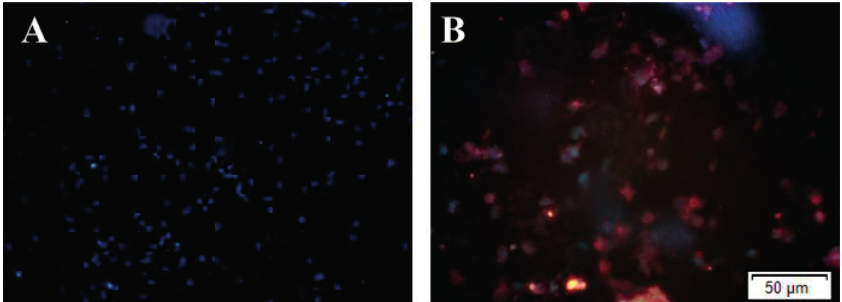
Figure 1. The comparison of A β production levels between N2a-WT and N2a-APP cells. Both WT-N2a and N2a-APP cells were cultured with 10 μ mol/L folic acid. Subsequently A β was detected by immunofluorescence staining (red), nucleus staining by DAPI (blue). ( A ) Representative images showing A β immunofluorescence in N2a-WT cells; ( B ) Representative images showing A β immunofluorescence in N2a-APP cells. Scale bar = 50 μ m.